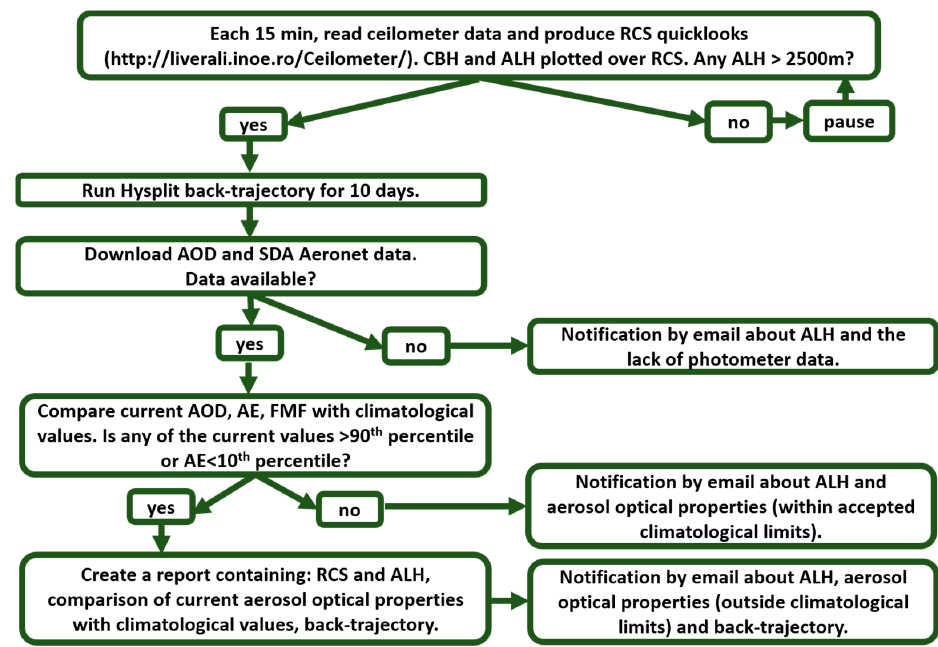
Figure 1. Methodology flowchart. RCS—range-corrected signal. CBH—cloud base height. ALH— aerosol layer height. AOD—aerosol optical depth. SDA—spectral deconvolution algorithm. AE— Angstrom exponent. FMF—fine-mode fraction.